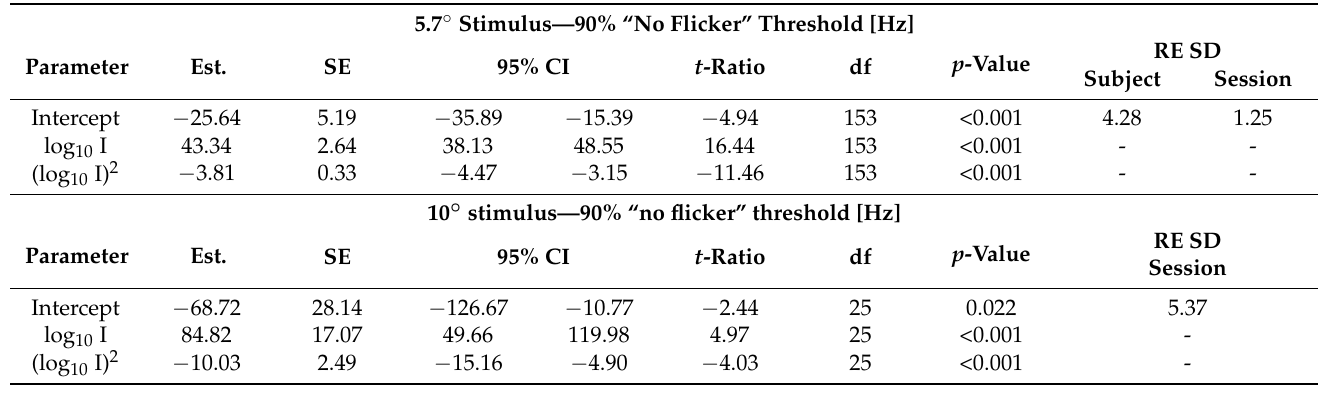
Table 3. Linear mixed model results of the 90% “no flicker” threshold as a function of log10 retinal illuminance and squared log10 retinal illuminance. The parameters estimate (Est.), their standard errors (SE) and 95% confidence intervals (95% CI) are shown, as well as the t-test results and the standard deviation of the different random effects included (RE